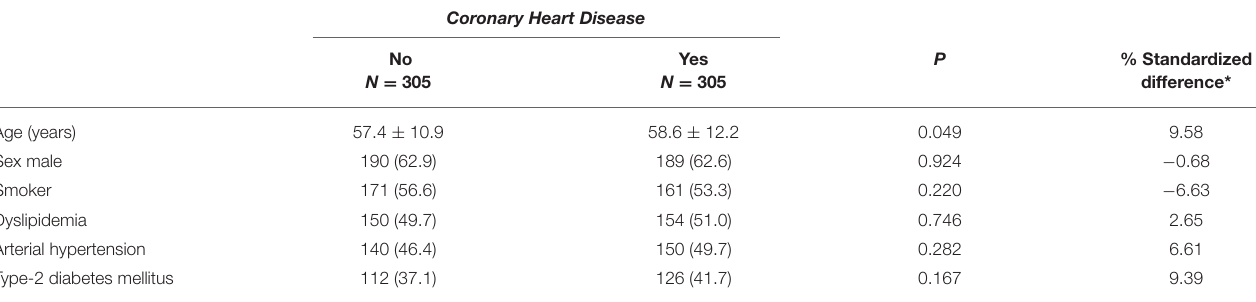
TABLE 4 | Patient characteristics of the study cohorts after Propensity score matching.